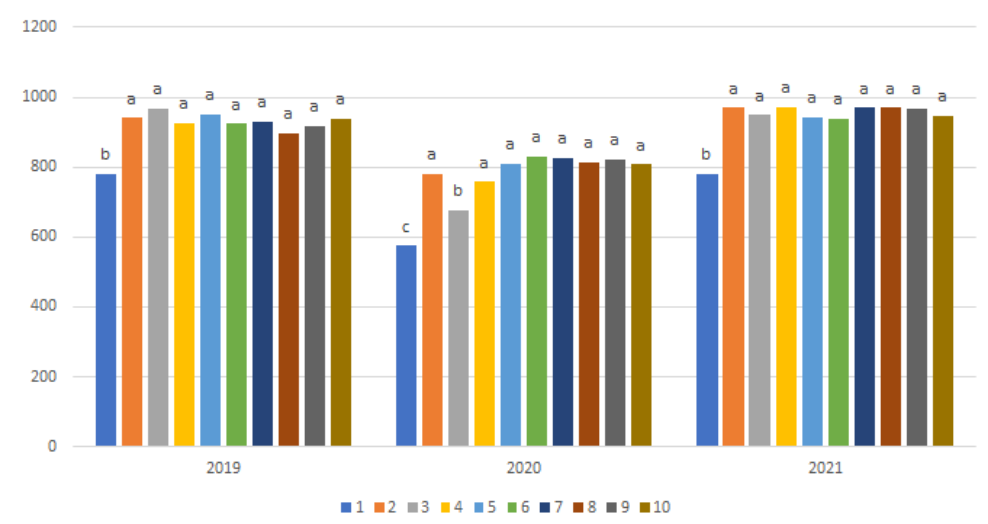
Figure 3. Fm (maximum fluorescence) results for maize in individual years of research. Different letters indicate statistically different mean LSD (0.05): 2019 = 85.29; 2020 = 62.31; 2021 = 102.31. The combination numbers are as specified in Tables 5 and 6.